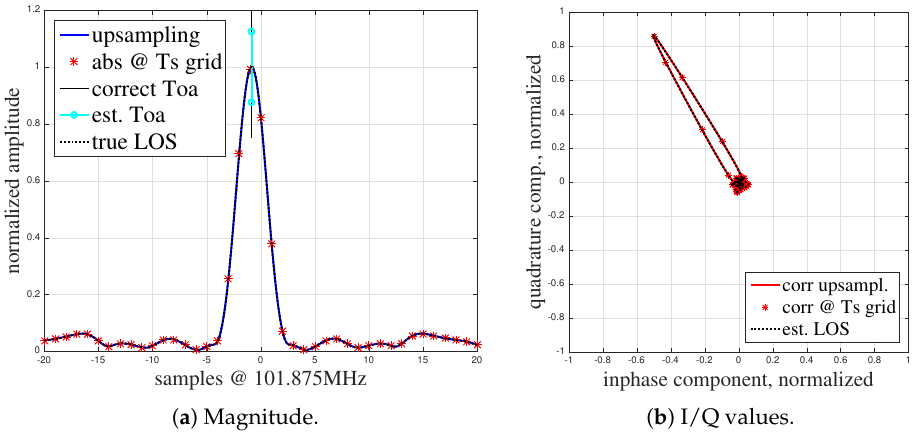
Figure 1. Characteristics of the correlation